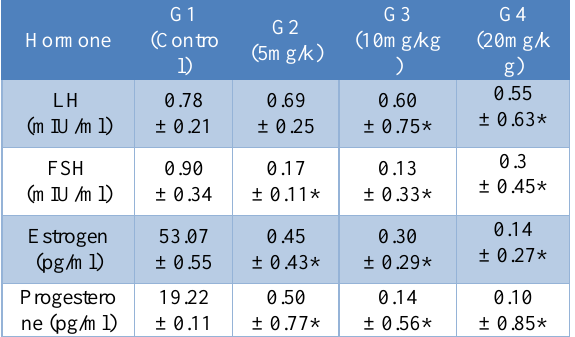
Values are given as mean ± SEM for each group. * indicates a significant difference (p˂0.05) between treated groups compared to control group. Statistical level of significance was determined by one-way